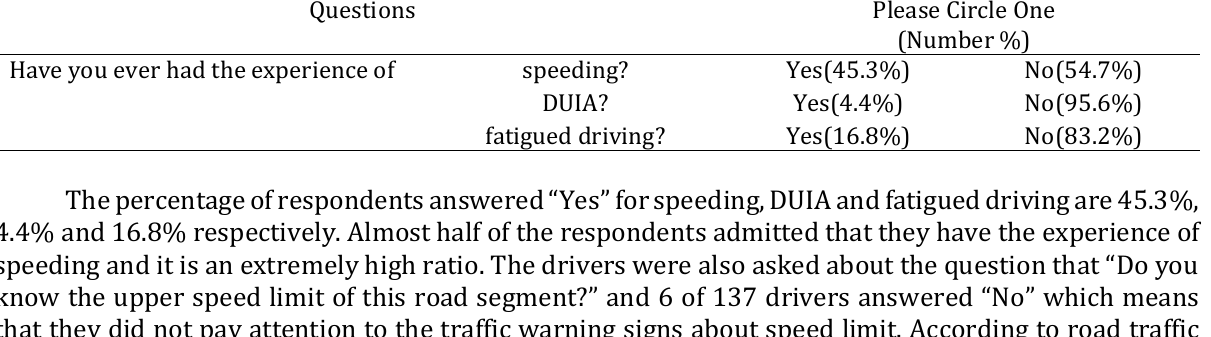
Table 1: Questions and